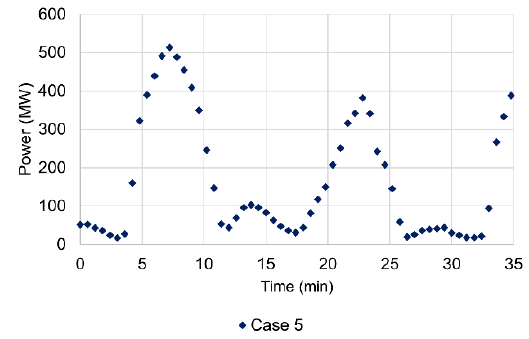
/ wind) for Case 5.